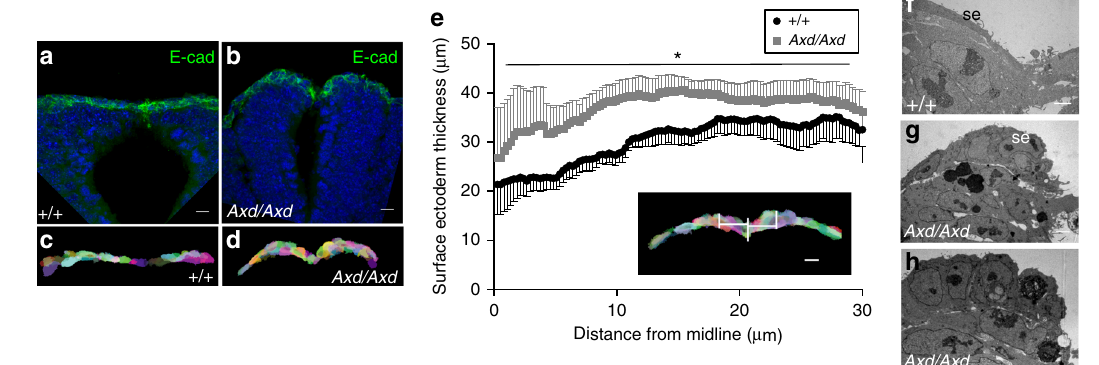
Fig. 7 Increased thickness of surface ectoderm in Axd/Axd embryos. a – e Surface ectoderm cells overlying the dorsal neural tube were segmented using z- stacks from E-cadherin (green) stained transverse sections ( a , b ) at the PNP closure site of E9.5 embryos, using Seedwater Segmenter ( c , d ). Scale bars: 10 μ m. e Thickness of the segmented surface ectoderm was determined across a 30 μ m interval either side of the midline, with a measurement taken every 0.26 µ m ( n = 6 + / + , n = 8 Axd/Axd ; * p < 0.001 by mixed model, thickness varies with genotype). Scale bar: 10 µ m. Data are represented as mean ± SEM. f – h Representative transverse TEM images show the cuboidal phenotype of surface ectoderm (se) cells in Axd/Axd mutants ( g and h ) in comparison with the fl at cells in + / + ( f ). Scale bars: 2 µ m. se: surface ectoderm. Source data are provided as a Source Data fi